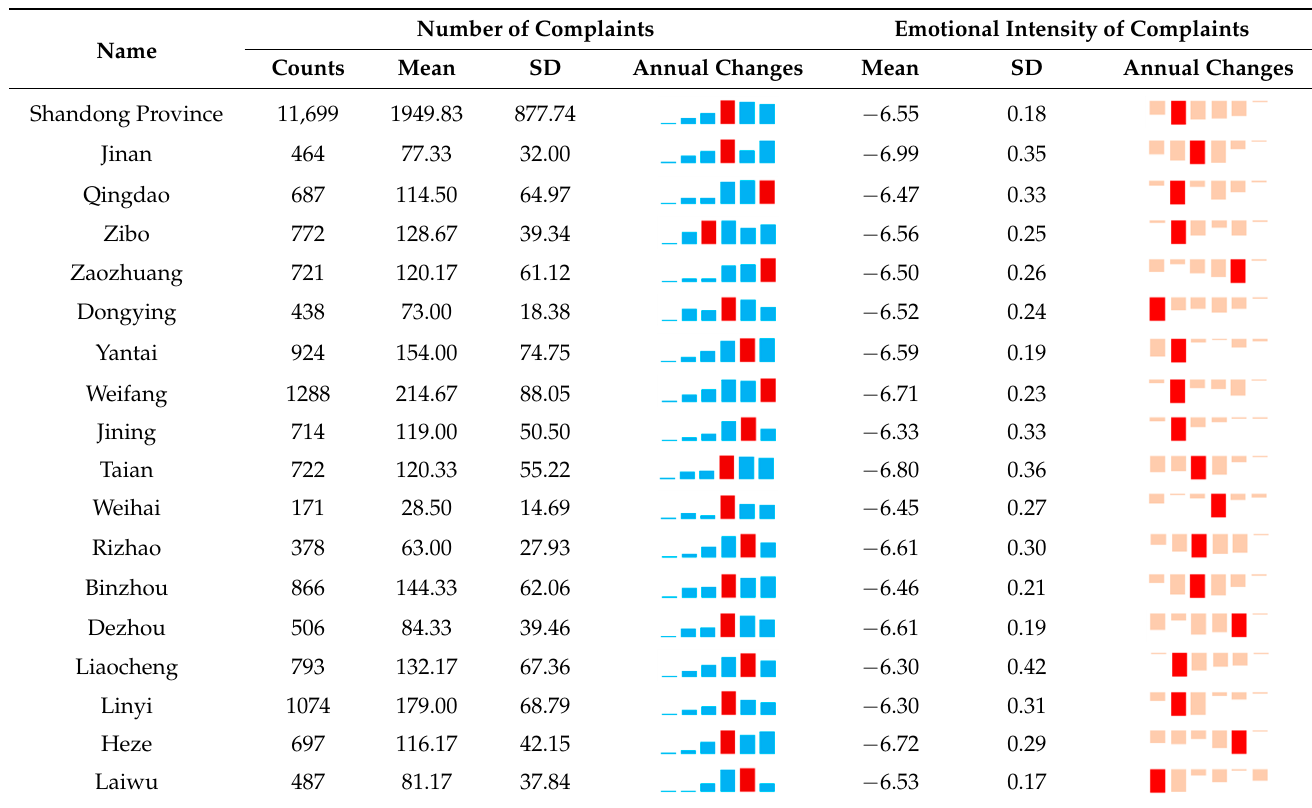
Table 4. Descriptive statistics of public complaints about air pollution in Shandong Province from 2012 to